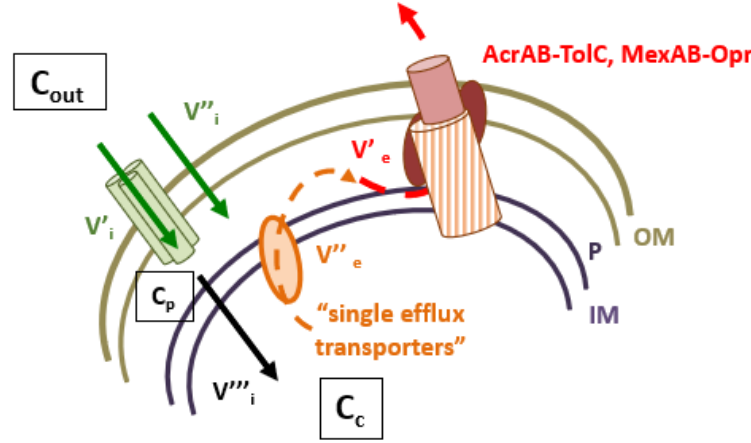
Figure 1. Intracellular concentration of antibiotics and RND efflux pumps. V’ i and V” i represent the influx rate across the outer membrane, V”’ i represents the diffusion rate across the inner membrane. C out , C p and C c represent the external, periplasmic and cytoplasmic concentration of antibiotics, respectively. V” e and V’ e represent the efflux rate accross the inner and outer membranes. AcrAB-TolC and MexAB-OprM illustrate the archetype of efflux pumps detected in clinical isolates. Importantly, clinical strains express a basal level of efflux pumps and can overproduce them via mutation in regulators (negative or positive), stimulation by external stresses,